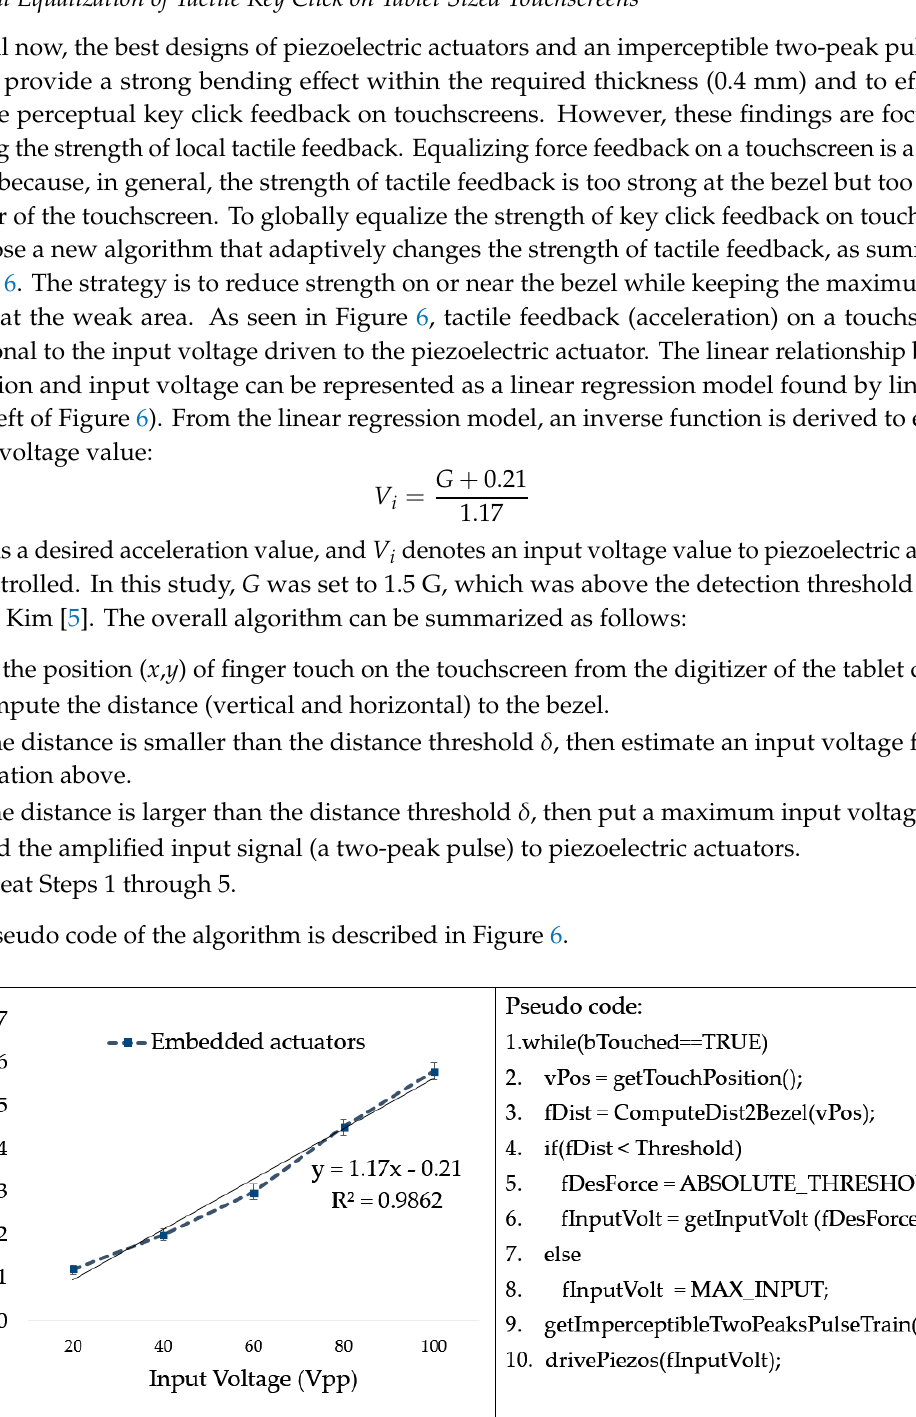
Figure 5. Discrimination thresholds (temporal sensitivity) estimated on tactile key click effects on tablet touchscreens: thresholds estimated per participant (left) and the average thresholds (right) for the haptics alone (H) and haptics with audible sound (HA) conditions.